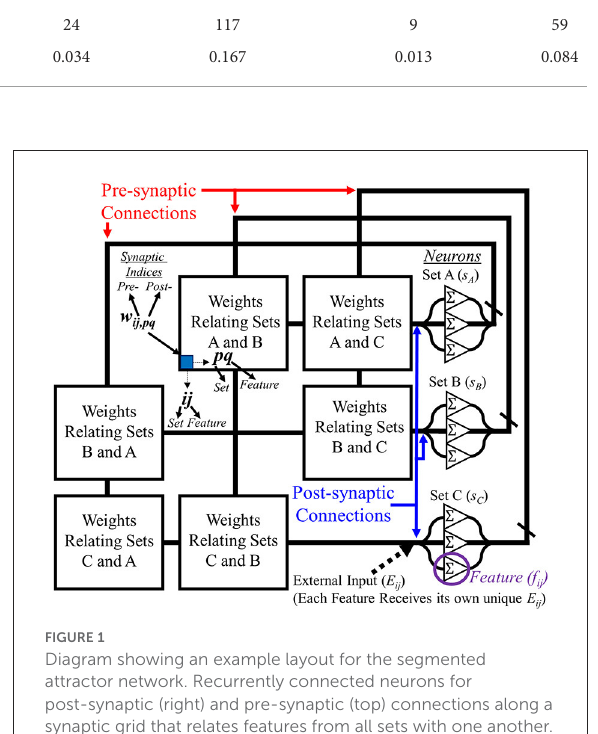
FIGURE1 Diagram showing an example layout for the segmented attractor network. Recurrently connected neurons for post-synaptic (right) and pre-synaptic (top) connections along a synaptic grid that relates features from all sets with one another. Sets do not relate features within themselves with one another, forming an empty diagonal through the network to help keep information